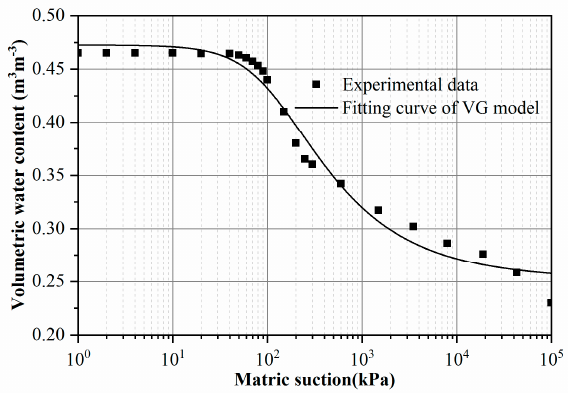
Figure 2. The soil–water characteristic curve of the expansive soil sample.